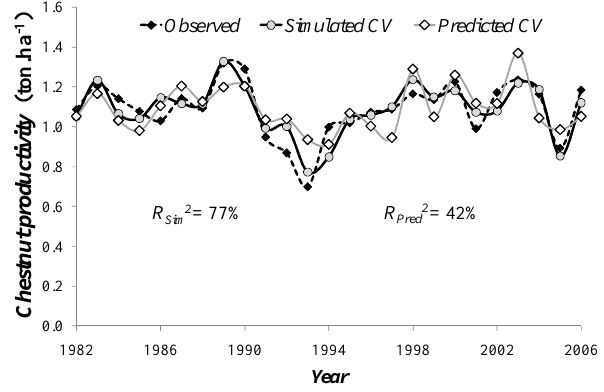
Figure 5. Values of observed (dashed with diamonds) and modelled with cross validation 2 Fig. 5. Values of observed (dashed with solid diamonds) and mod- (CV) with simulation (solid with grey circles) and prediction (solid light grey with white 3 elled with cross-validation (CV) with simulation (solid with grey diamonds) model of detrended chestnut productivity in Portugal, for the 25-year period, 4 circles) and prediction (solid light grey with white diamonds) model defined from 1982 to 2006. 2 R -values between observed and modeled time series with CV 5 of detrended chestnut productivity in Portugal, for the 25-yr period, are also shown. 6 defined from 1982 to 2006. R 2 -values between observed and mod- elled time series with CV are also